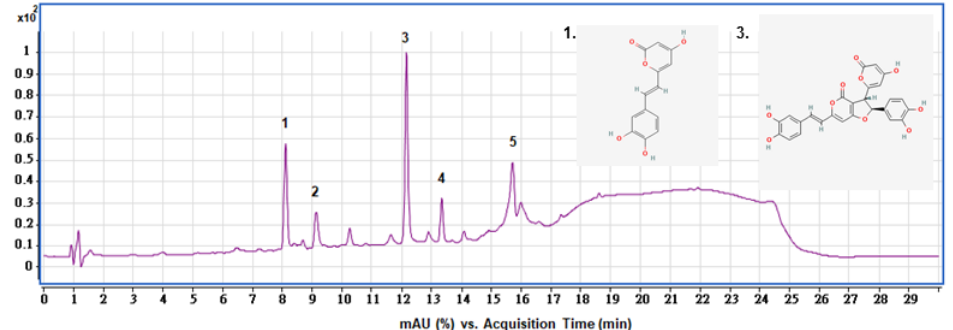
Figure 2. Representative HPLC profile of main constituents present in the SPEE. The diode-array detector was utilized at the wavelength of 210 – 600 nm in the HPLC analysis. Peak 1: hispidin; 2: MW. 490; 3: hypholomine B; 4: hypholomine B isomer; 5: unidentified compound. Chemical structures of 1 and 3 from PubChem are cited in the